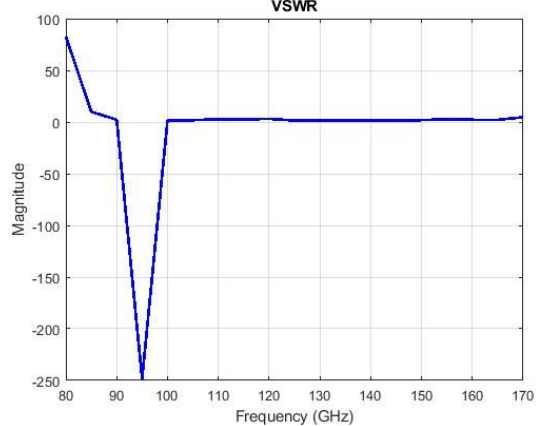
Figure 14. Impedance versus frequency.